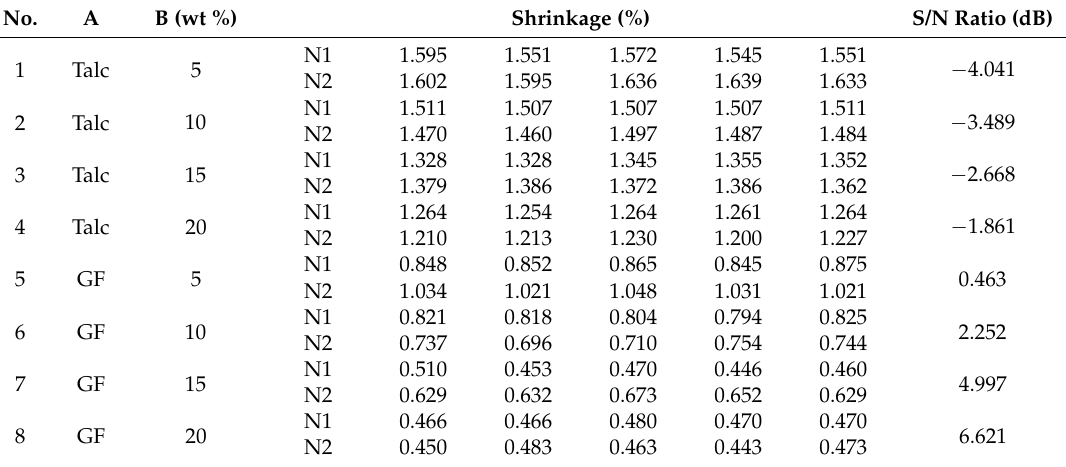
Table 10. S/N ratio of shrinkage in the transverse direction.